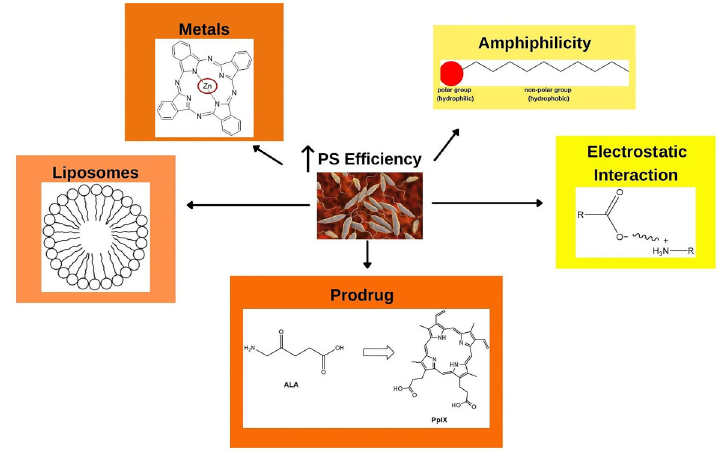
Figure 3. Key features to consider in increasing the effectiveness of photosensitizers (PS) against Leishmania